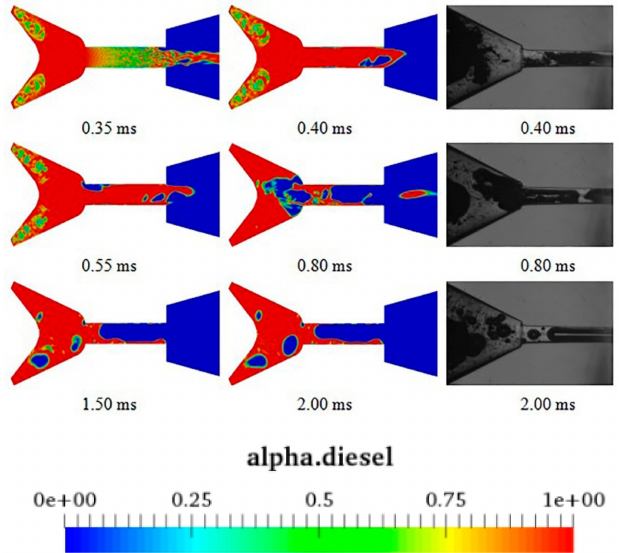
Figure 6. Volume fraction of diesel in the nozzle after injection (AI). At 0.55 ms, the external air flowed back into the orifice inlet, and the cavitation in the orifice disappeared completely. At 0.8 ms, with the collapse of the cavitation in the sac, the external air also back-flowed into the sac. At 1.5 ms, the cavitation in the nozzle disappeared completely, the gas part in the nozzle was all ingestion gas. Due to surface tension, the gas ingestion bubbles began to fuse and became brighter, more transparent, and regular. When the nozzle was in the static state (2.0 ms), the gas ingestion bubbles were fully fused and occupied 3/4 of the length of the